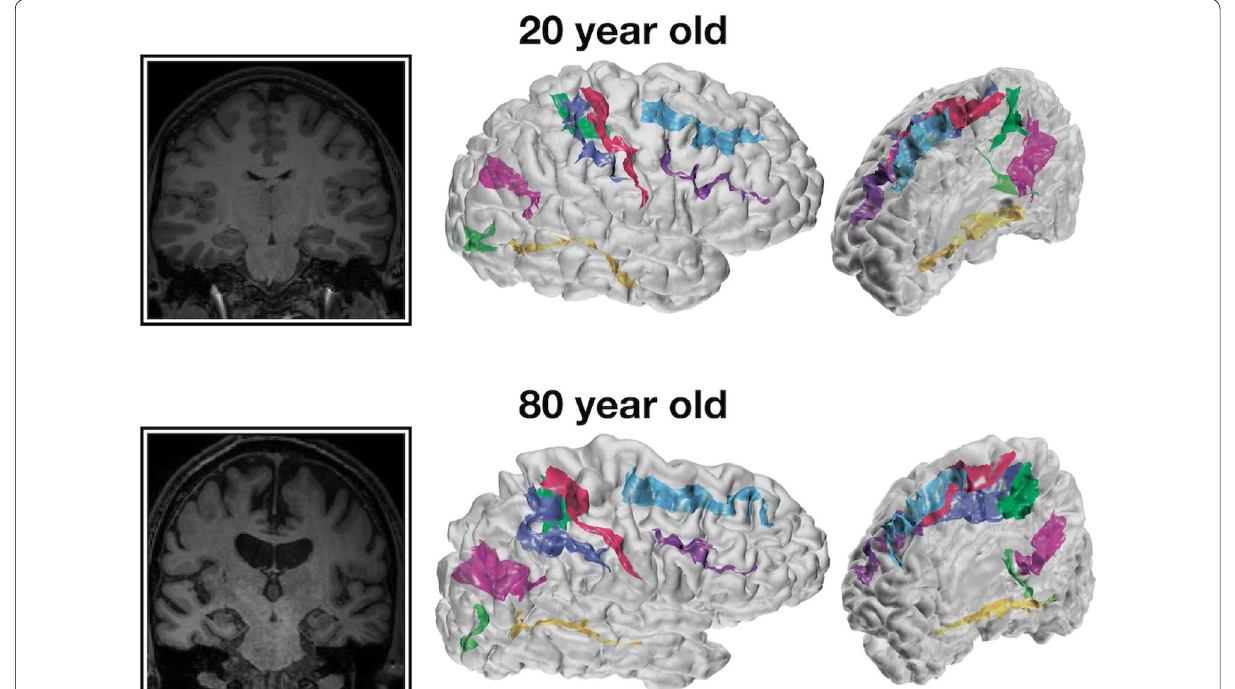
Fig. 1 Representative coronal slices and cortical surfaces with sulcal identification for 20- and 80-year-old